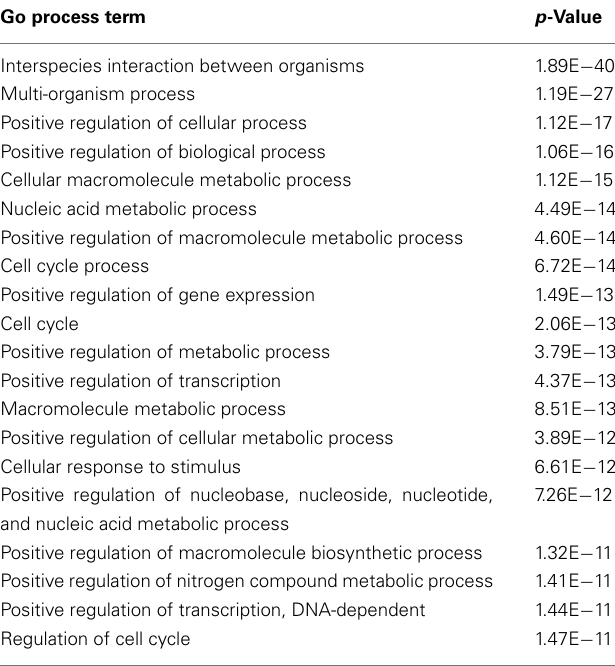
Table 3 | First 20 enriched GO process terms in human proteins targeted by at least three bacterial groups (three-bacteria-targeted set).